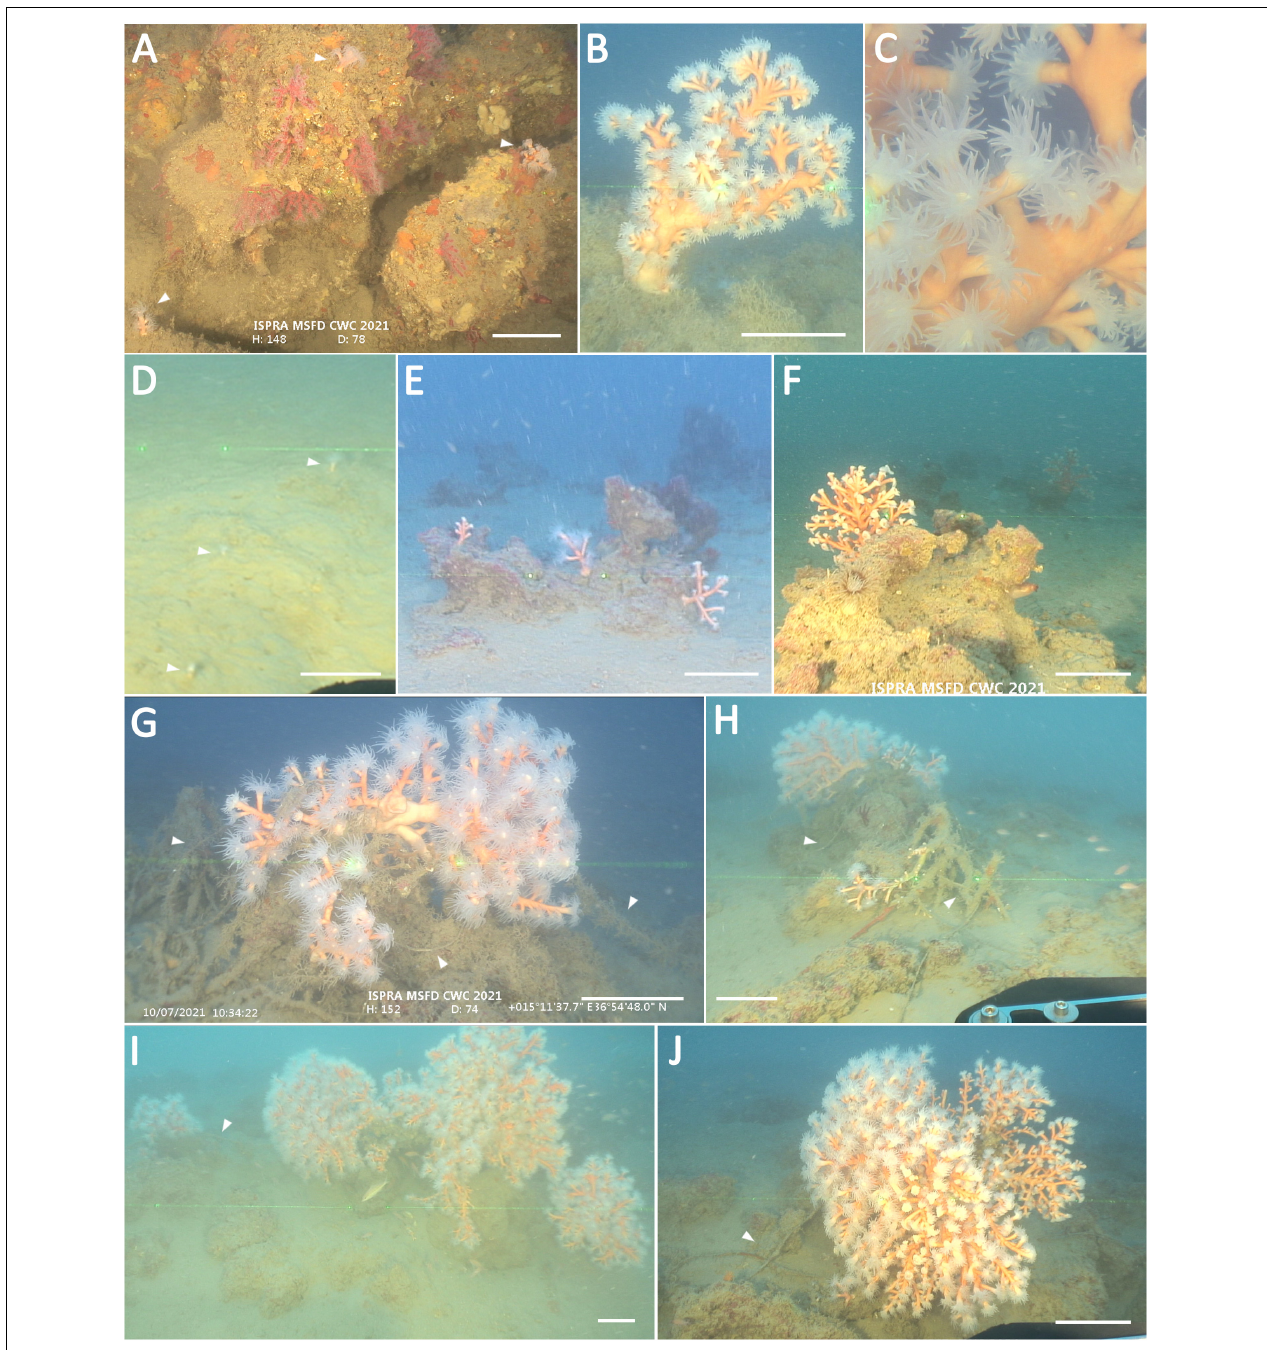
FIGURE 3 | D. ramea and the anthropogenic impact in the study area. (A) D. ramea (white arrows) and healthy Corallium rubrum colonies dwelling on a rocky shoal. (B,C) Candelabra-shaped D. ramea colony with a close-up image. (D) Single corallites (white arrows) on the soft bottom. (E,F) Boulders with different sized branched colonies of D. ramea . (G,H) Larger colonies of D. ramea entangled and broken by old lines (white arrows). (I,J) Very large bushy-shaped colonies of D. ramea abraded by lines (white arrows). Approximated scale bar: 16 cm.